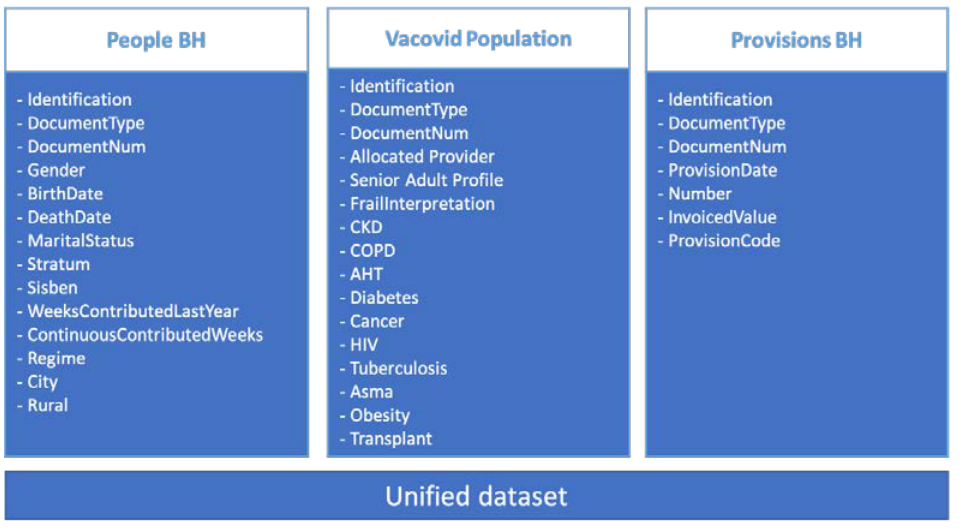
Figure 2. Variables by source.